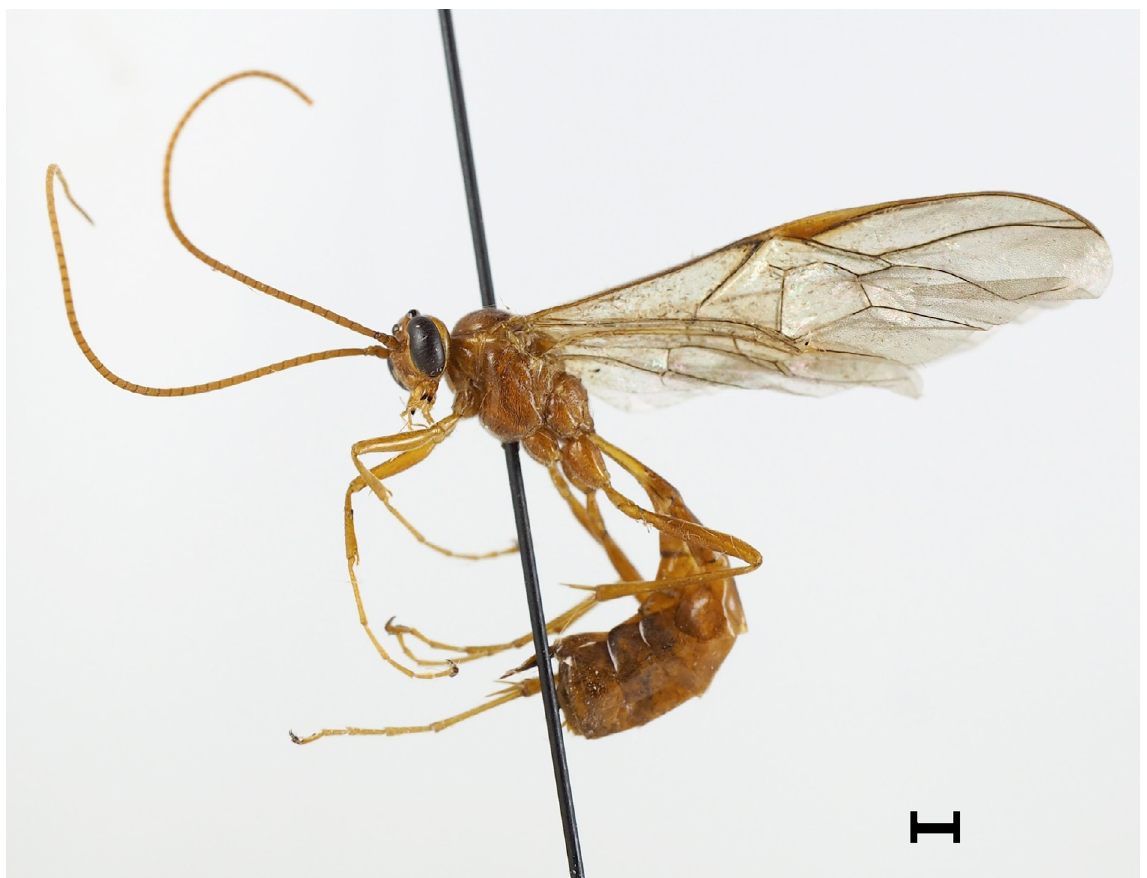
Fig. 29. Ophion confusus Johansson sp. nov., holotype, ♀ (NHRS-HEVA000008637). Scale bar = 1